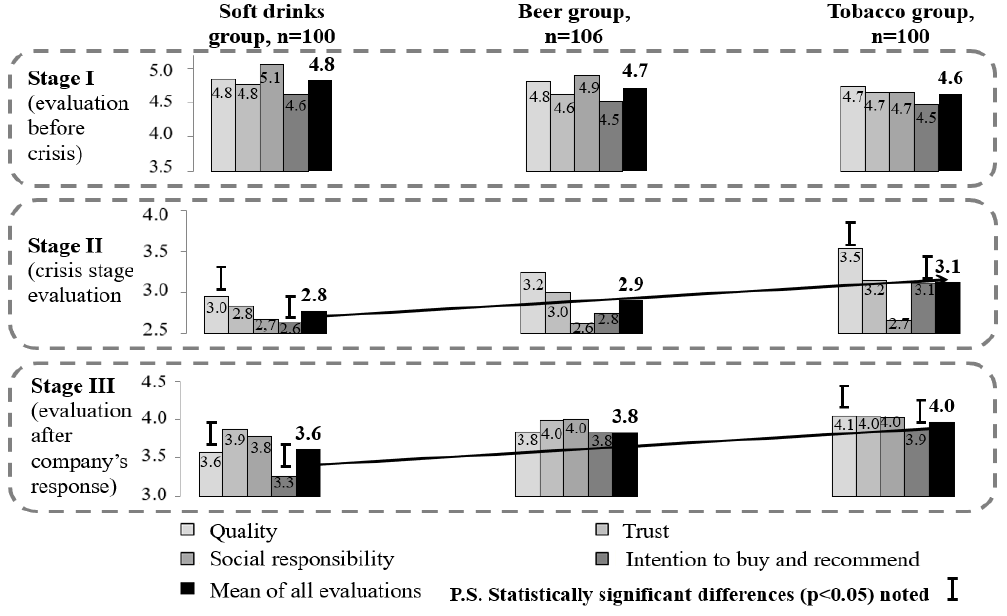
Fig. 1. Comparison of the results of experiment between the control and experimental groups during different phases of the experiment (the mean averages of evaluation of consumers’ reactions are provided on a 7 points